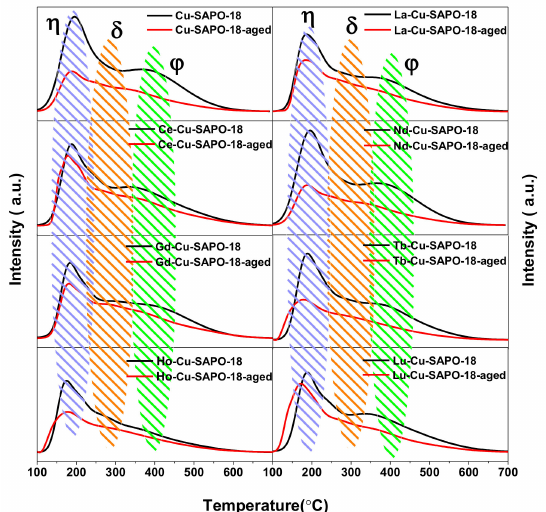
Figure11. NH 3 -TPDprofilesofthefreshandhydrothermallyagedCu-SAPO-18andM-CuSAPO-18samples. Table 4. Acidity of the Samples Obtained from Their NH 3 -TPD Profiles. Acidity (mmol / g) Amount Sample (mmol / g) Weak Moderate